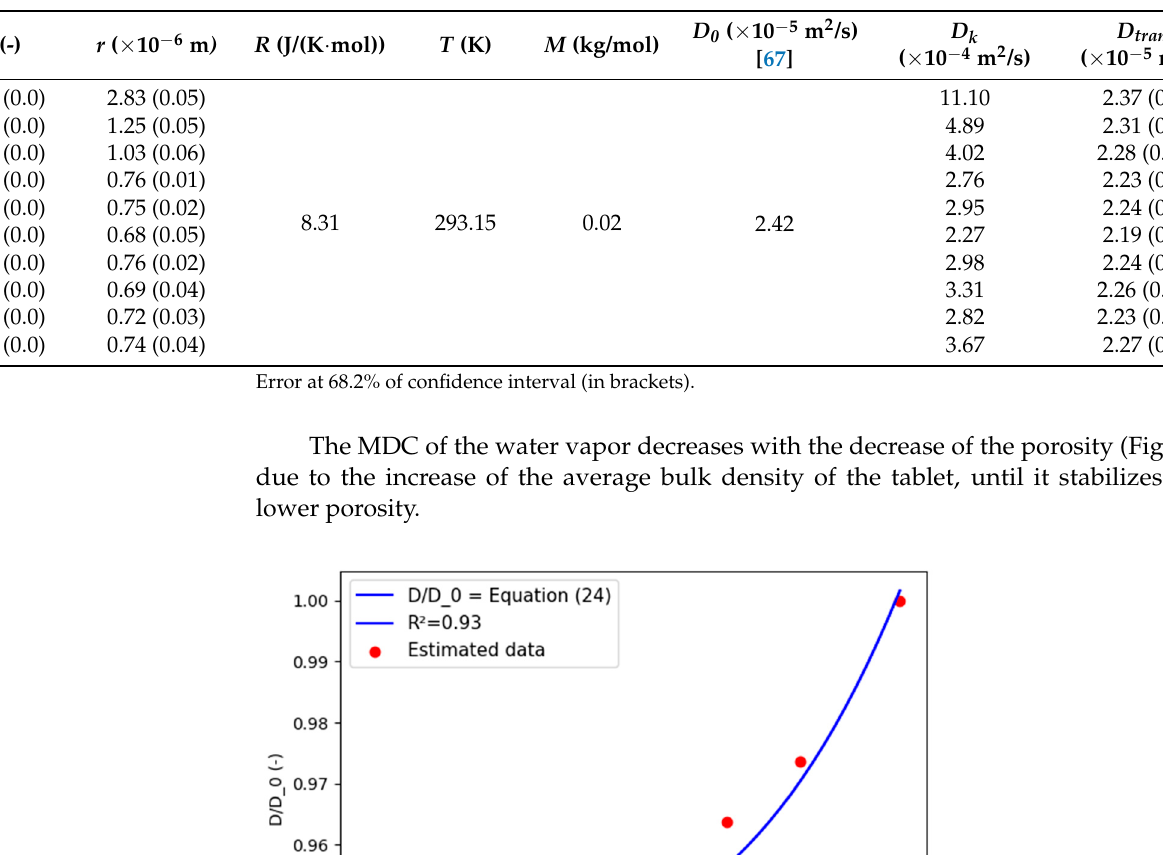
Table 6. Calculated transitional diffusion at each relative density.